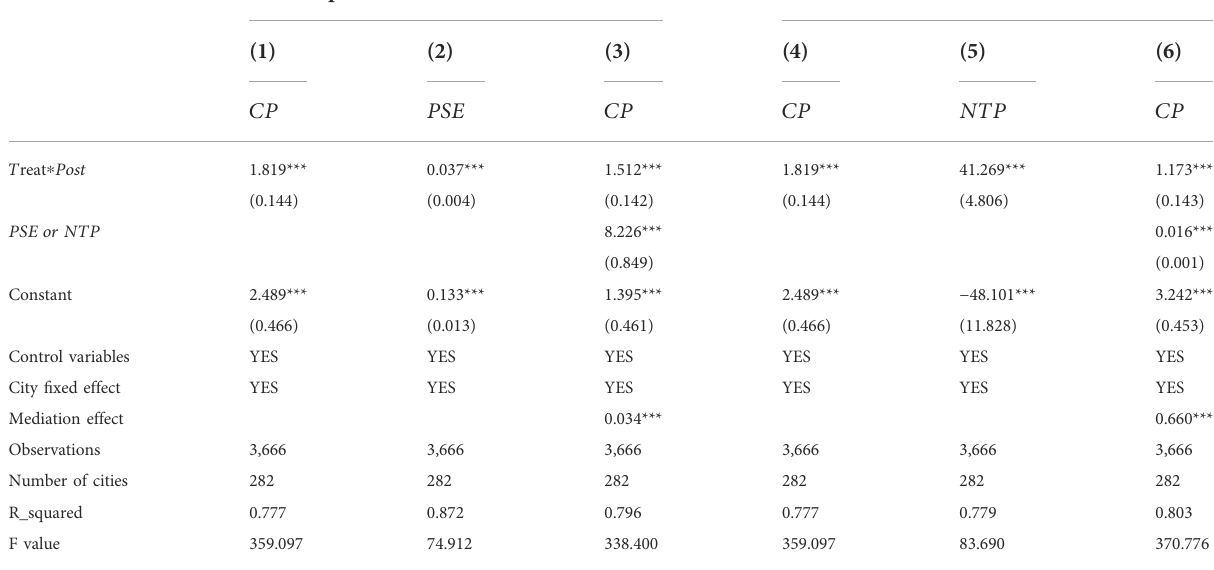
TABLE 9 Estimation results based on energy